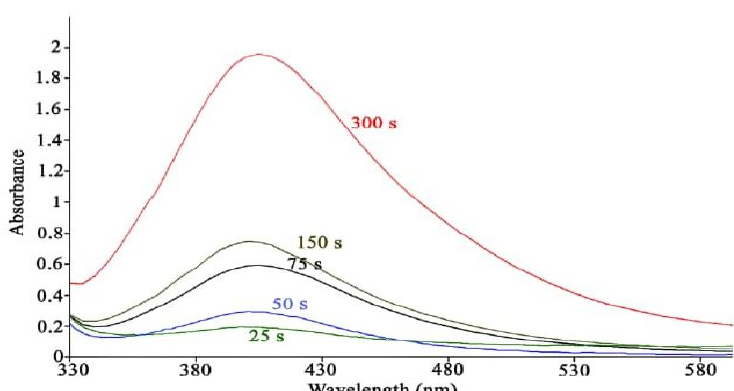
Fig. 1. The ultraviolet–visible spectrum of silver nanoparticles synthesized by electrochemical method in different time intervals of 25, 50, 75, 150 and 300 seconds (1 amp current and rotation speed of 3000 rpm).